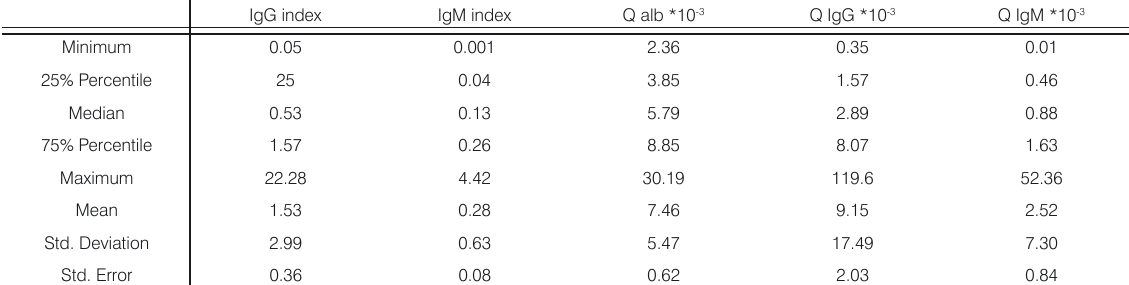
Table 3. Summarized results in patients with MS (continued).